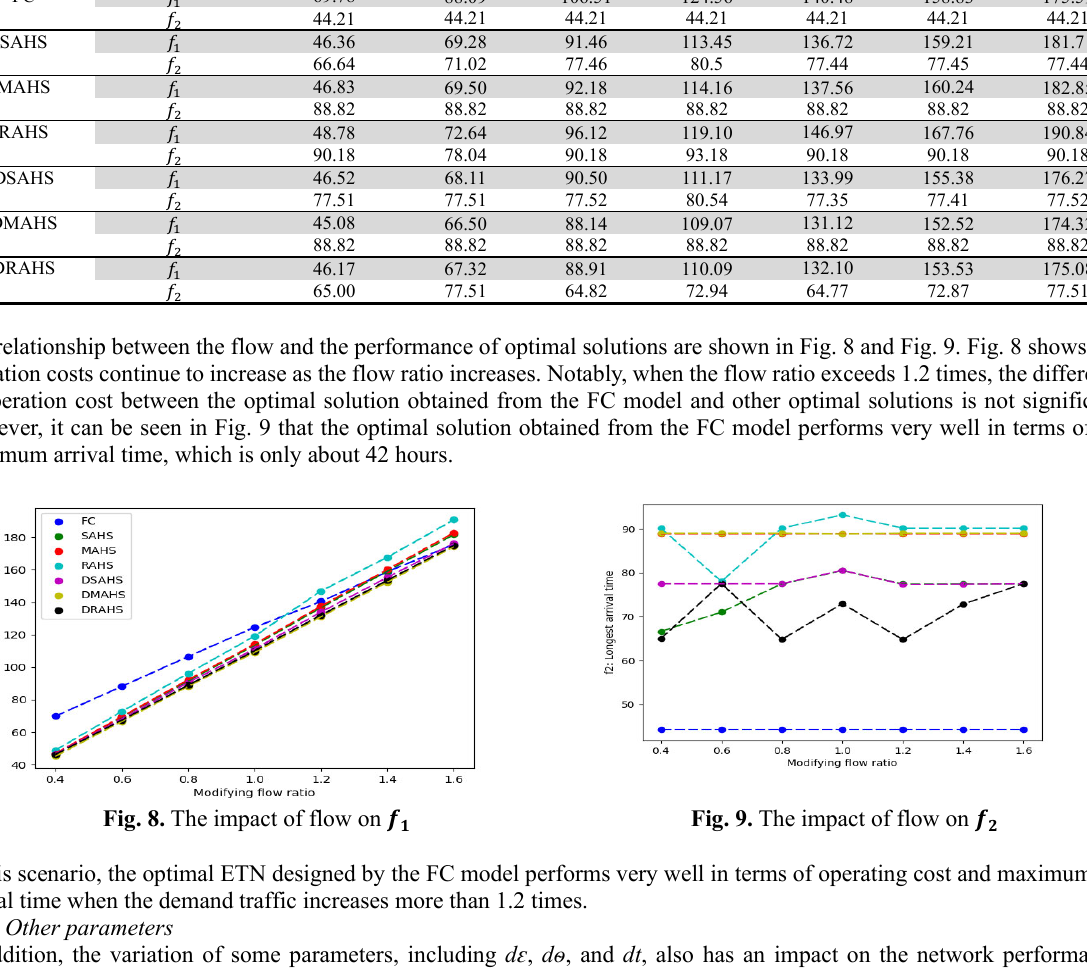
Fig. 8. The impact of flow on 𝒇